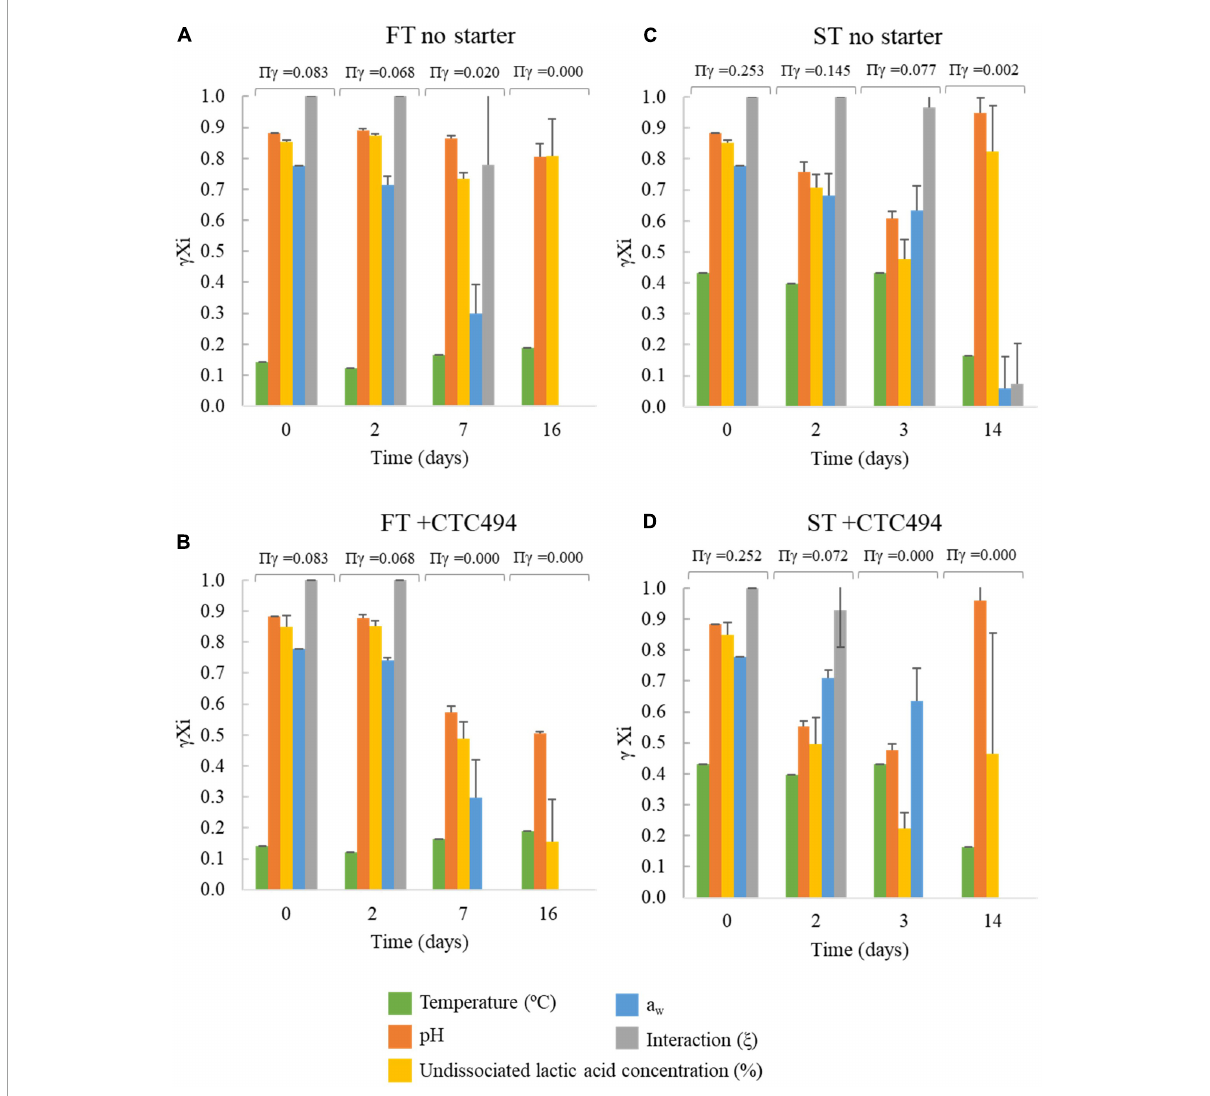
FIGURE5 Gamma ( γ ) values for each environmental factor considered in the predictive model used for simulating L. monocytogenes behavior during the fermentation and ripening of fuet type (FT) and snack-type (ST) sausages with no starter) (A,C) and with the addition of the bioprotective (sakacin K)-producing L. sakei CTC494 (B,D) . Error bars correspond to the standard deviation of the mean